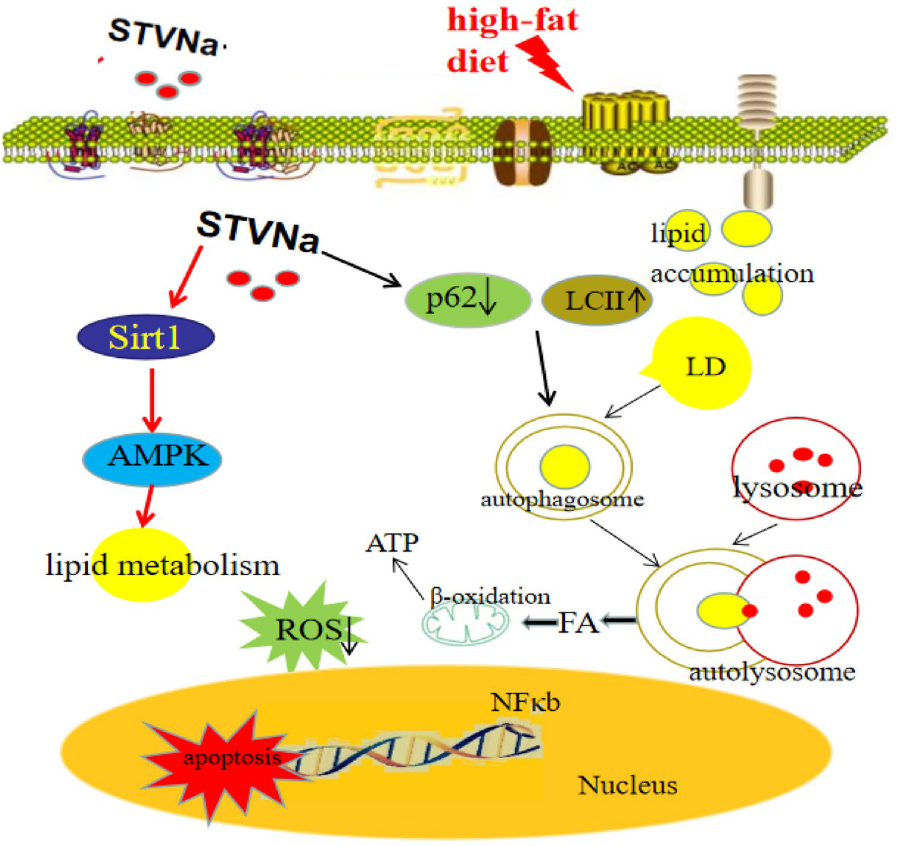
Figure 10. Mechanistic illustration of the effect of STVNa on FFA-induced NAFLD. STVNa increased SIRT1 expression, thus promoting lipid metabolism and inhibiting cellular ROS overload. In addition, STVNa